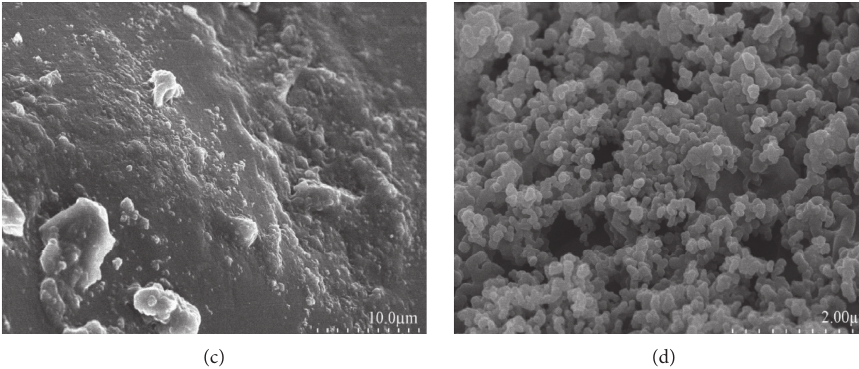
Figure 7: The results of SEM imaging of the coating surface after burning. (a) F3 (1.5 wt.% MWCNTs, 10 wt.% FA). (b) F2 (1 wt.% MWCNTs, 10 wt.% FA). (c) F4 (1 % wt.% MWCNTs, 0 wt.% FA). (d) F1: neat